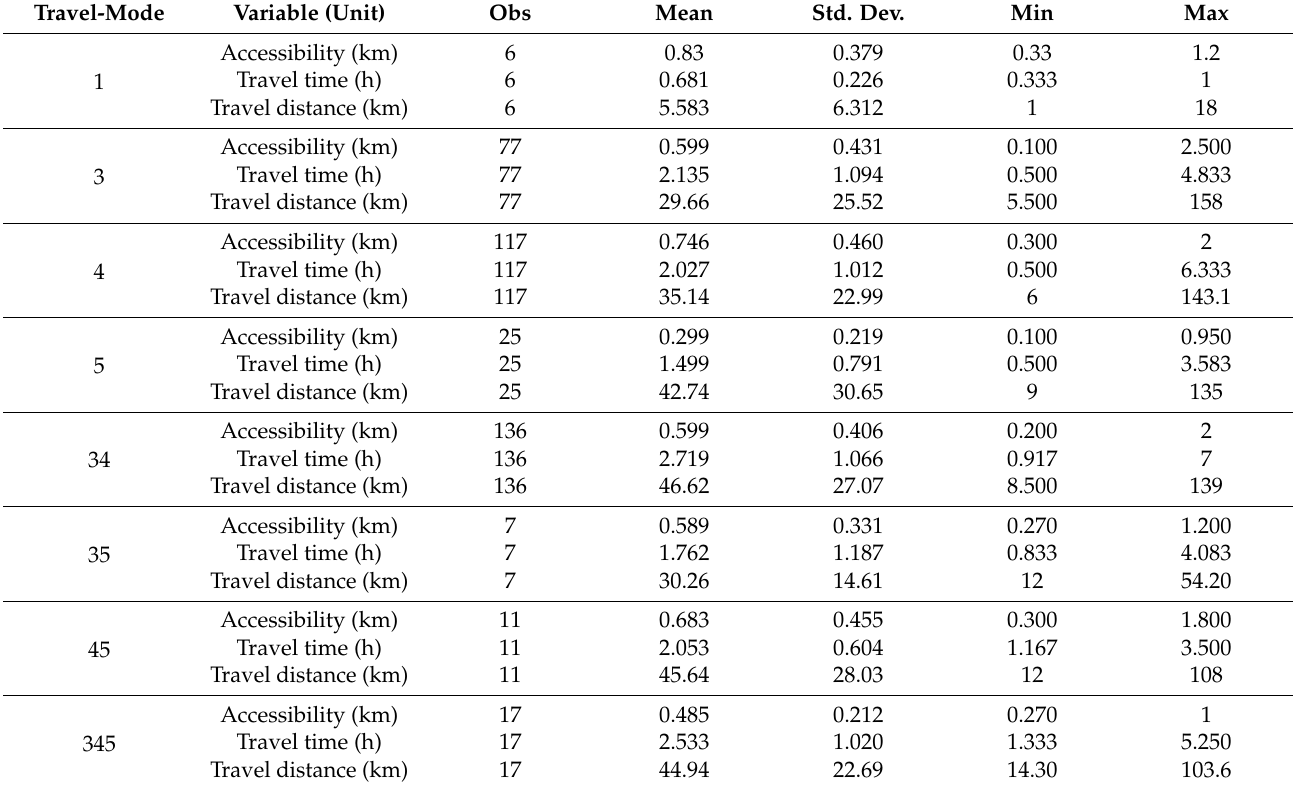
Table 7. Summary results of travel characteristics over different travel-mode